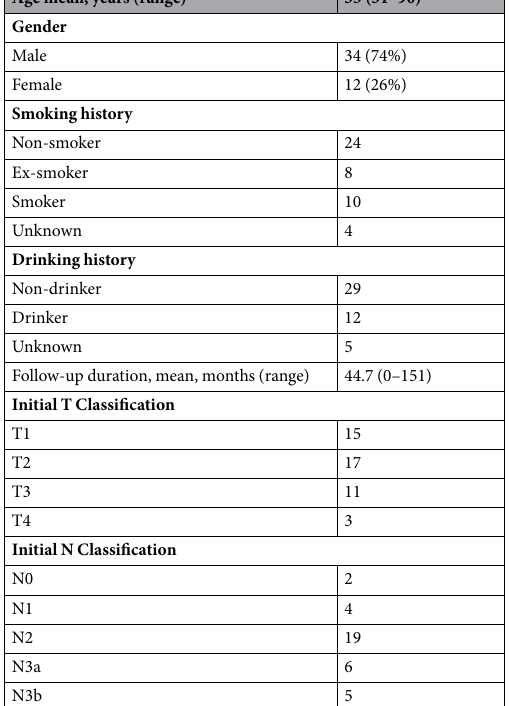
Table 1. Demographics. This table is a summary of the demographics and baseline charactersitcs of all